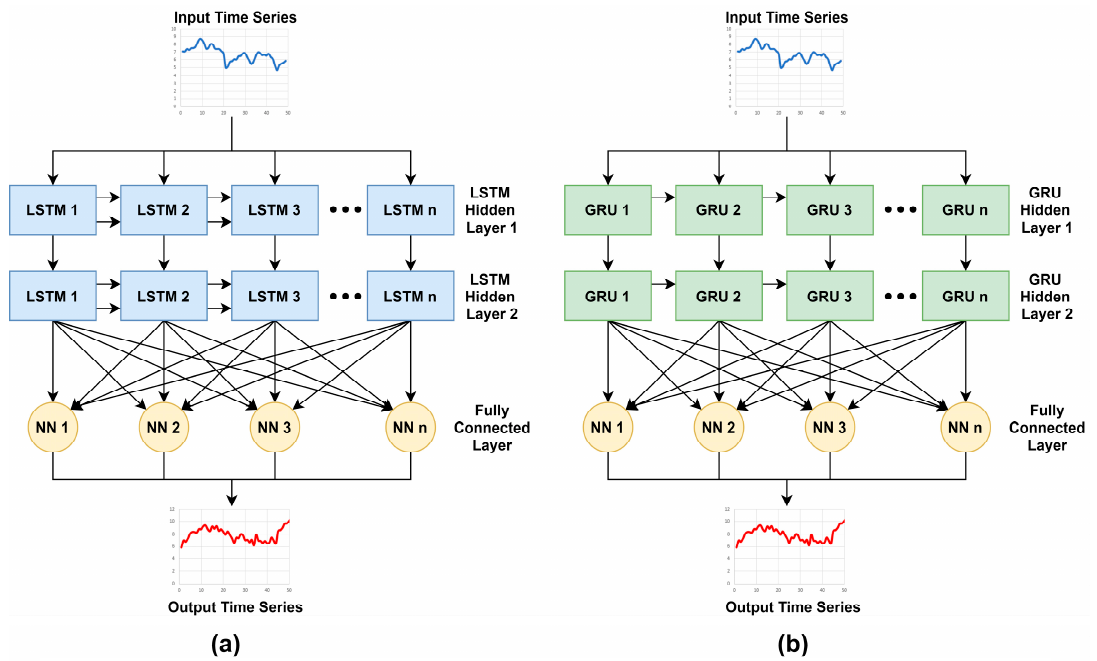
Table 1. LSTM model hyperparameters.